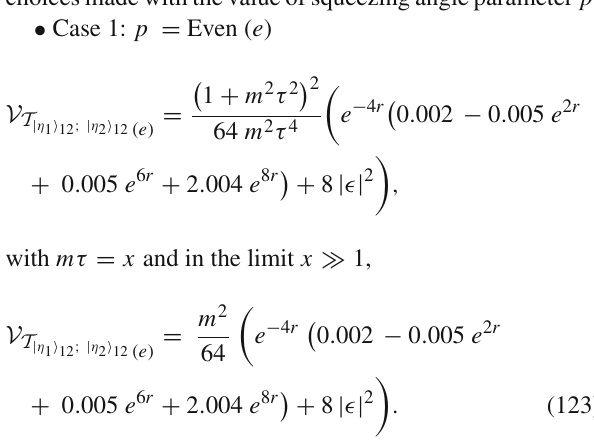
approximation to the gravity cannot be trusted. It is interest- ing to note that the nonclassical characters of the | η 1 (cid:3) and | η 2 (cid:3) states gets completely destroyed when coherent parameter ˆ T 002 :(cid:3) takes on further large values, for such a case (cid:2): | η (cid:3); | η (cid:3) 1 2 = (cid:2): ˆ T :(cid:3) 2 D T = 0, the region of 00 (cid:3); | η (cid:3) with | η | η 1 (cid:3) 12 ; | η 2 (cid:3) 12 ( e ) 1 2 classical